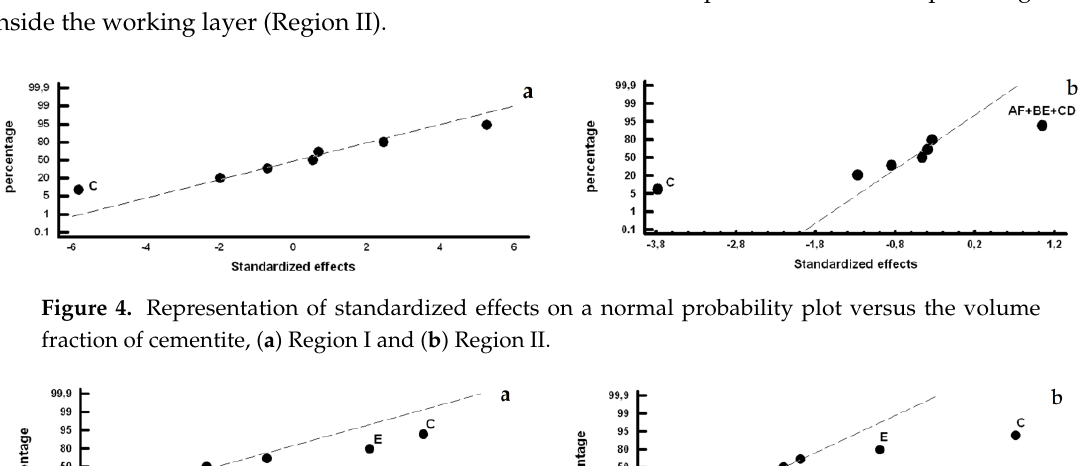
Figure 4. Representation of standardized effects on a normal probability plot versus the volume fraction of cementite, ( a ) Region I and ( b ) Region II.